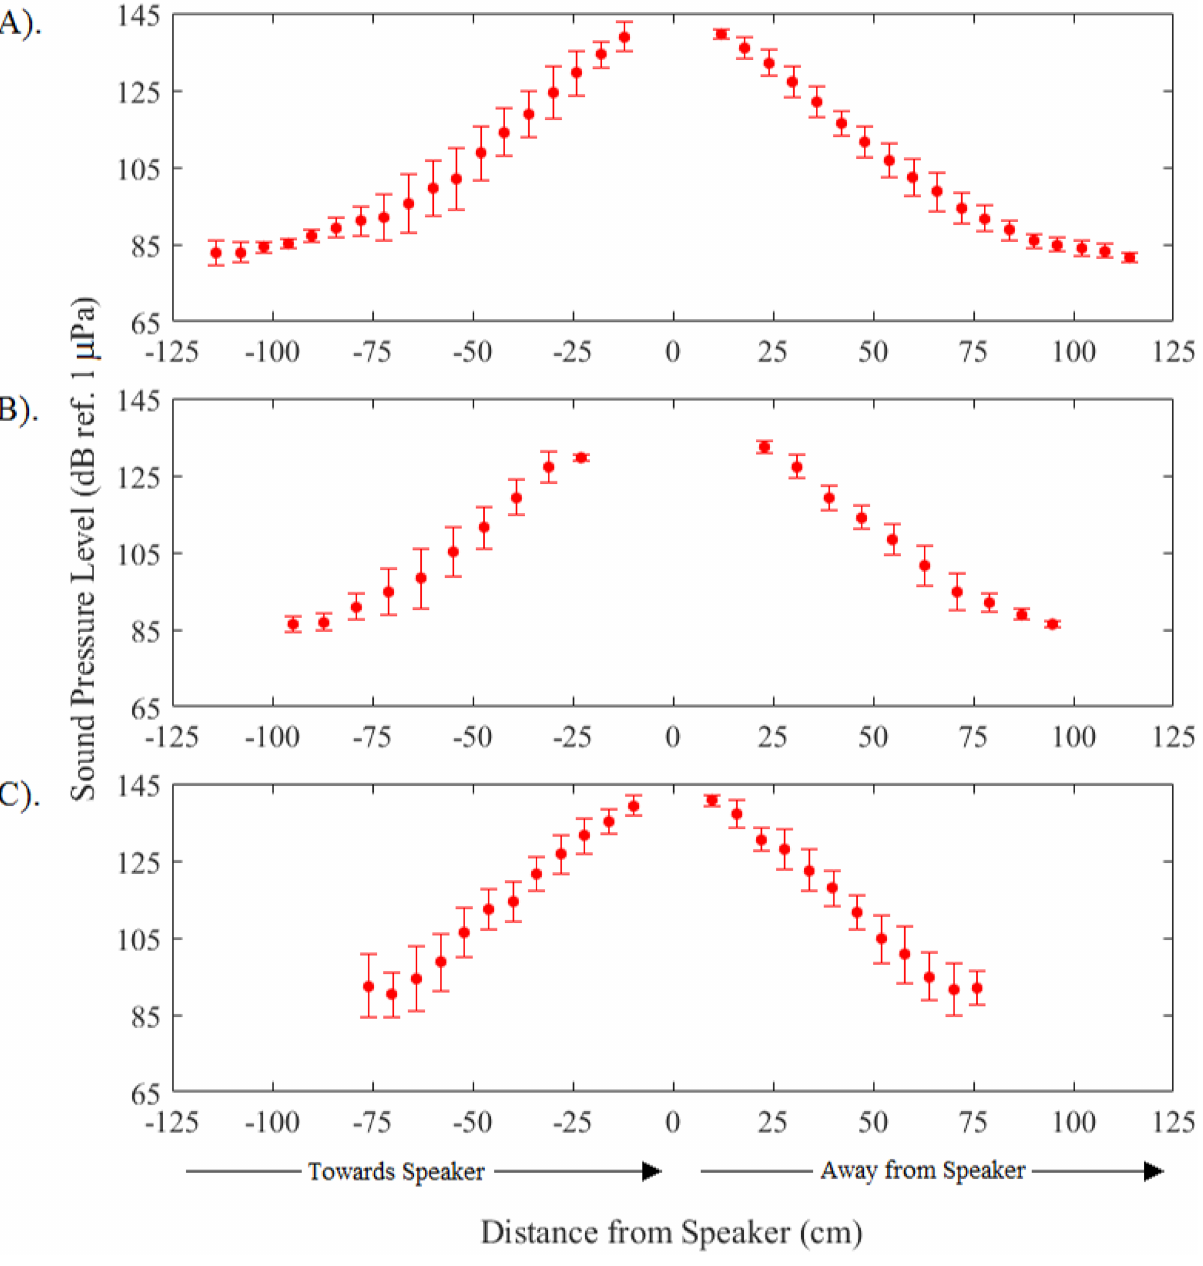
Fig 8. Mean sound pressurelevel along swimming trajectoryof (A) common carp, (B) silver carp, and (C) bighead carp. Trajectories were analyzedfrom all four trials. Negativedistances indicatemovement towards the speaker, whilepositive indicate movement away. Bars are the standard